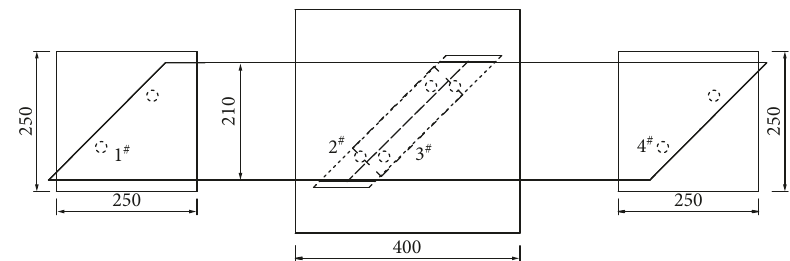
Figure 7: The bearing layout of two-span skew girder bridge test model schematic